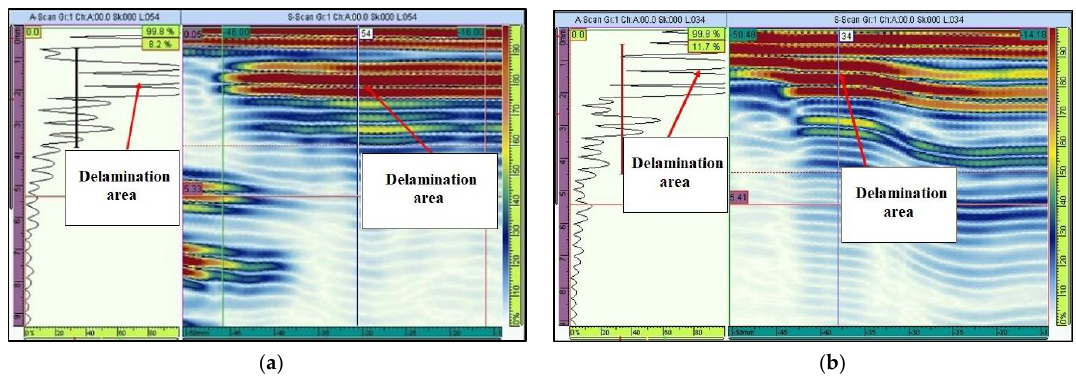
Figure 18. A-scan and S-scan of two damaged zones on the left side ( a ) and the right side ( b ) of impact simulation cut of multi-stringer component.